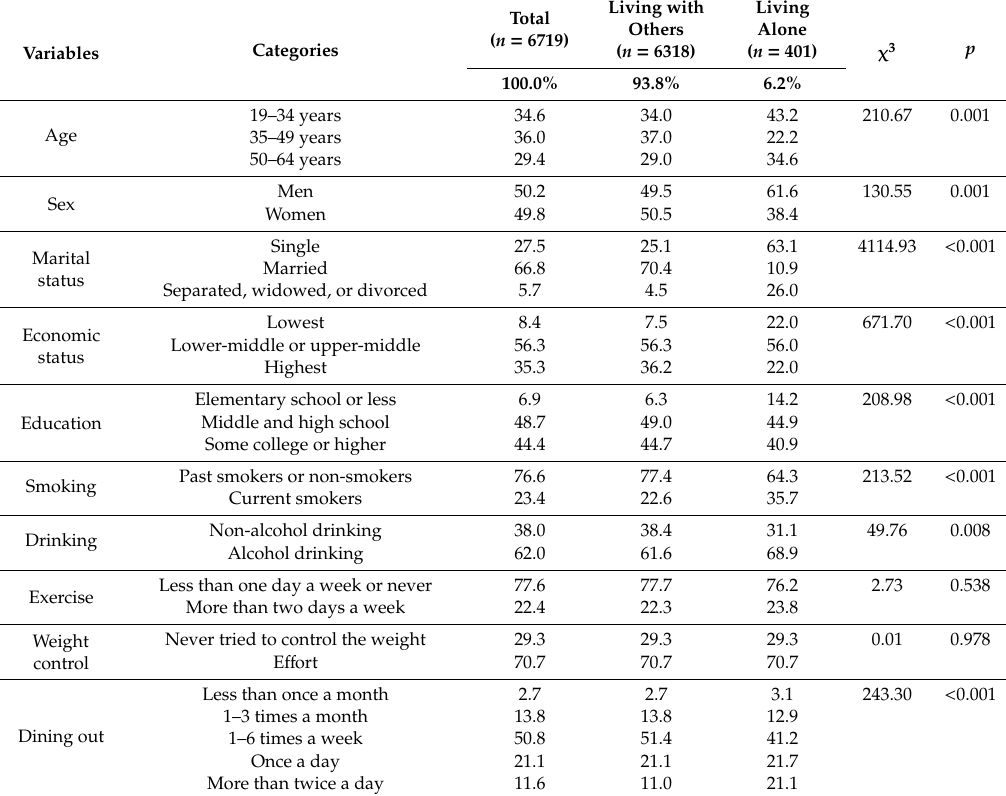
Table 1. Characteristics of participants by living arrangement ( n =